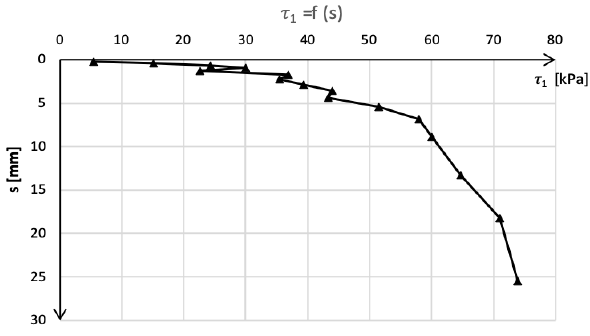
Figure 6b: Least squares method for Pile 2 N